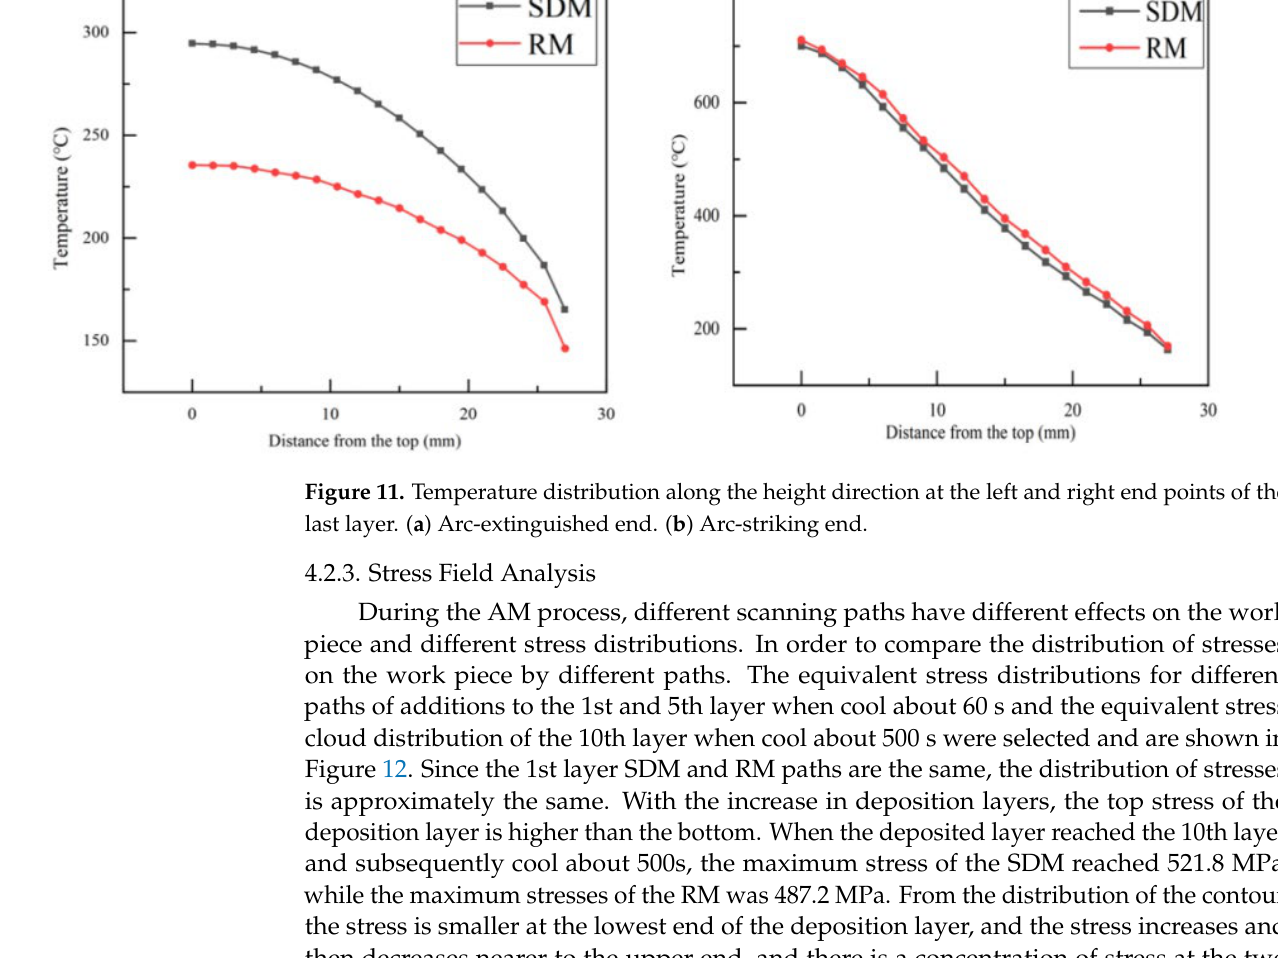
12 of 17 Figure 10. Thermal cycling curves at different midpoints for different paths. ( a ) SMD scan path. ( b ) RM scan path. When the heat sources move in a different way, the resulting temperature distribu- tion inside the workpiece will also be different. When the heat source moves to the middle of the 10th layer, the temperature distribution of the left and right two-end points along the height direction is, respectively, as shown in Figure 11. The temperature of the arc